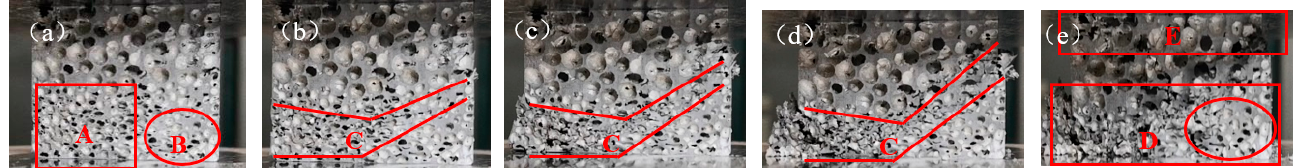
Figure 6. A macroscopic diagram of the deformation process of two-layered gradient Al foams with a cell size of 4-2. Deformation strain: ( a ) ε = 0.01, ( b ) ε = 0.08, ( c ) ε = 0.21, ( d ) ε = 0.38, ( e ) ε = 0.46; A indicates the area with thin cell wall, B indicates the area with relatively thick cell wall, C indicates local regional collapse deformation, D indicates obviously collapsed area, E indicates still intact overall cell shape.